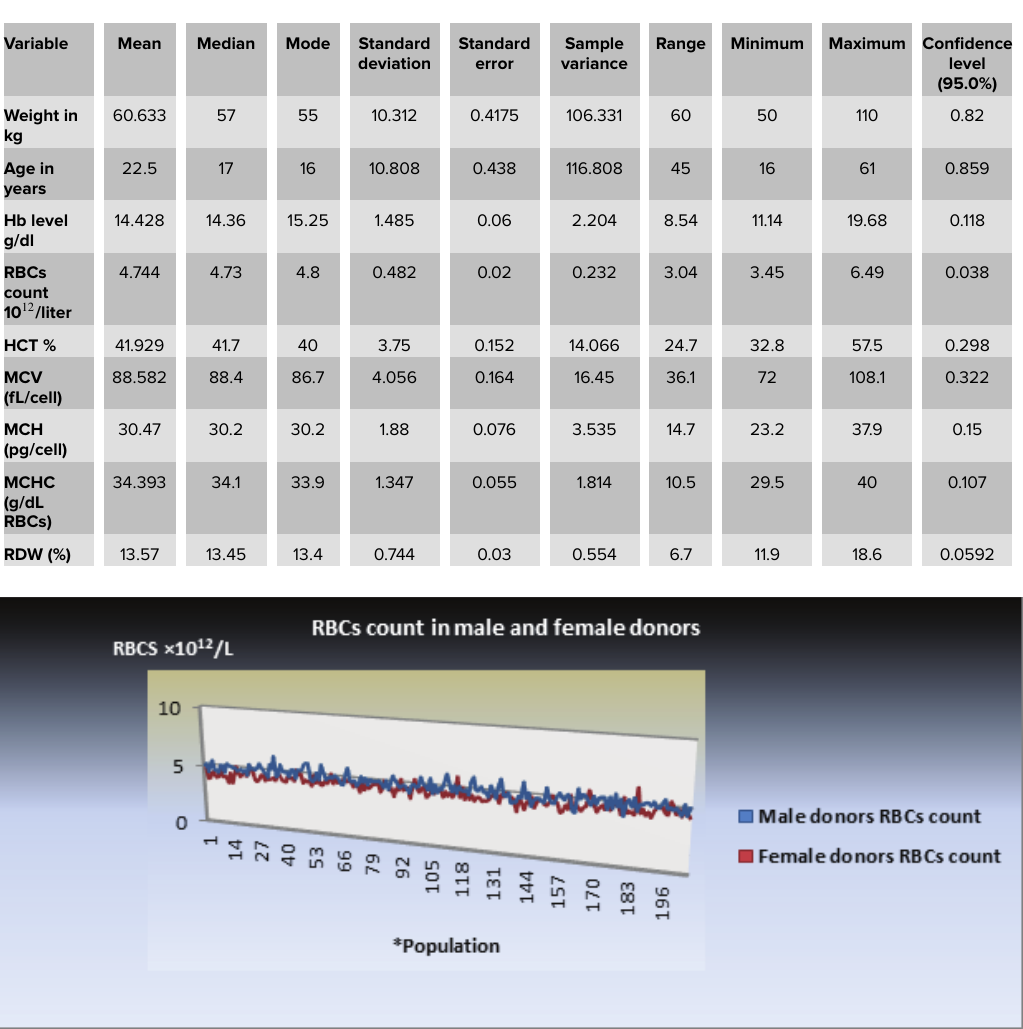
TABLE 1: The results calculated to eight variables in erythrocytes and hemoglobin.